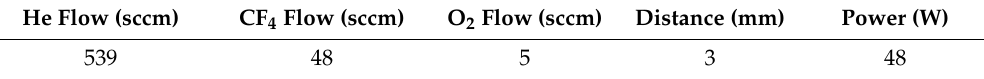
Table 1. Process parameters for removal investigation.